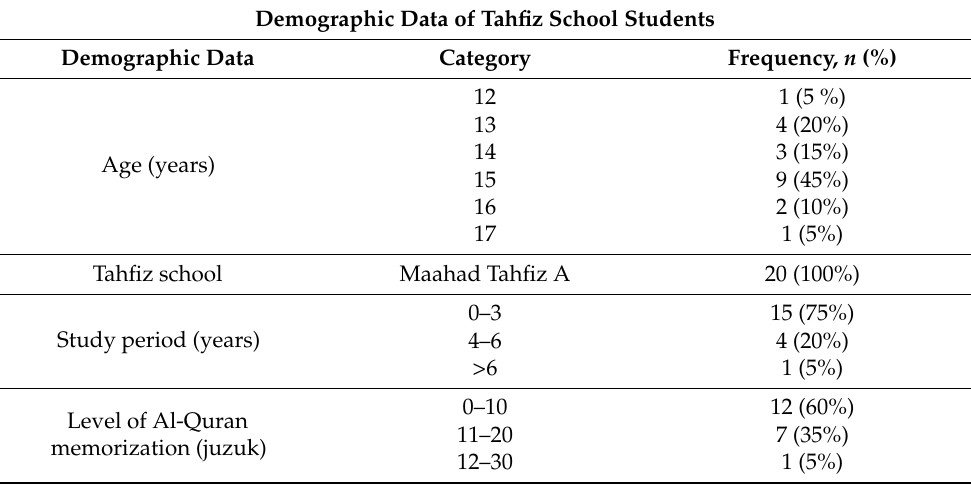
Table 2. Demographic data of Tahfiz school students and Tahfiz school